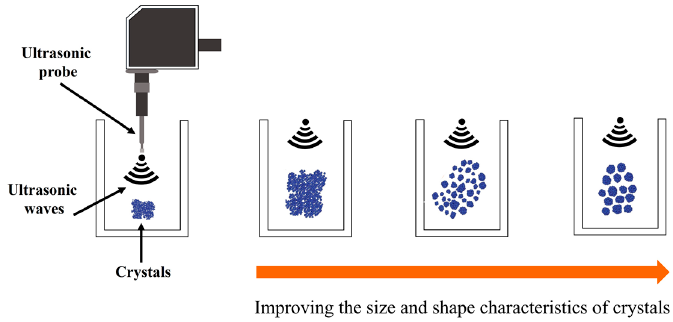
Figure 16. Schematic representation of the sonocrystallization process.